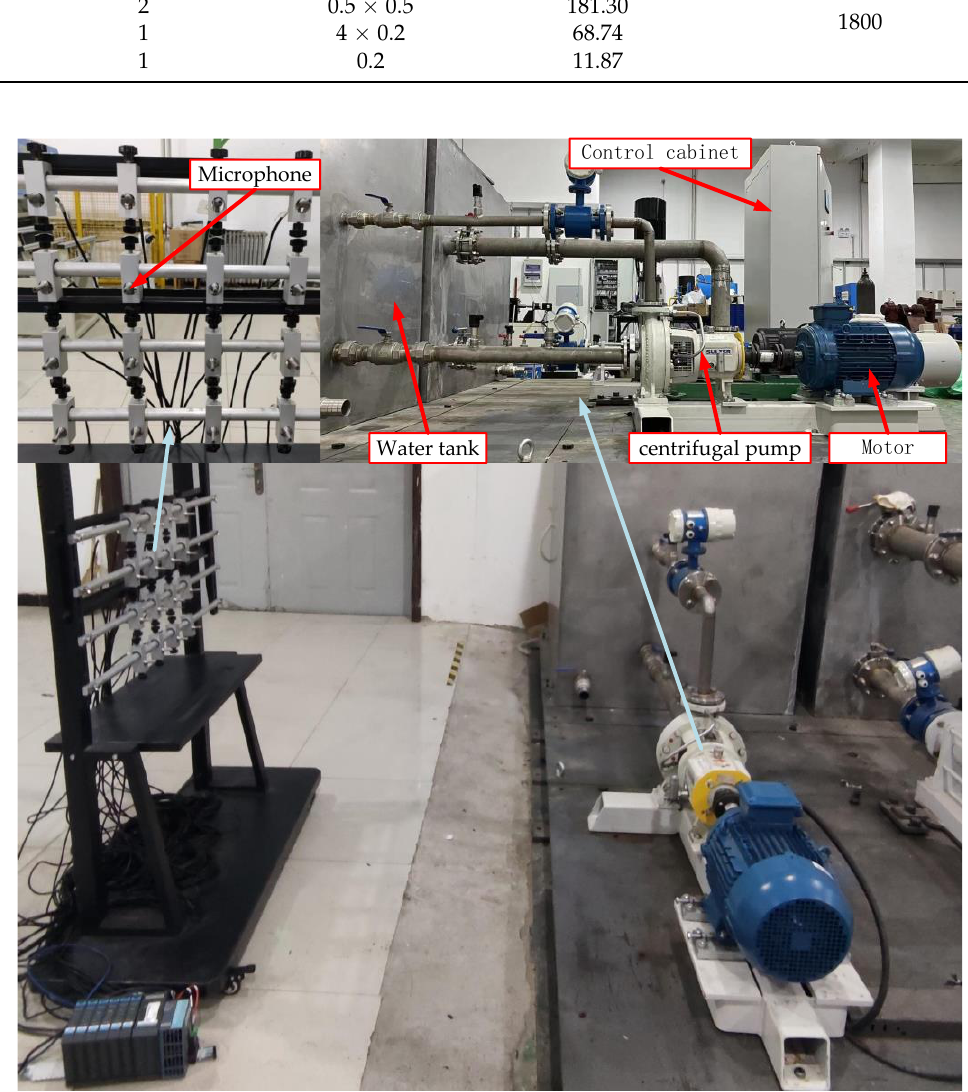
Figure 3. Layout of the centrifugal pump test bench, the rectangular microphone array and the data collector.